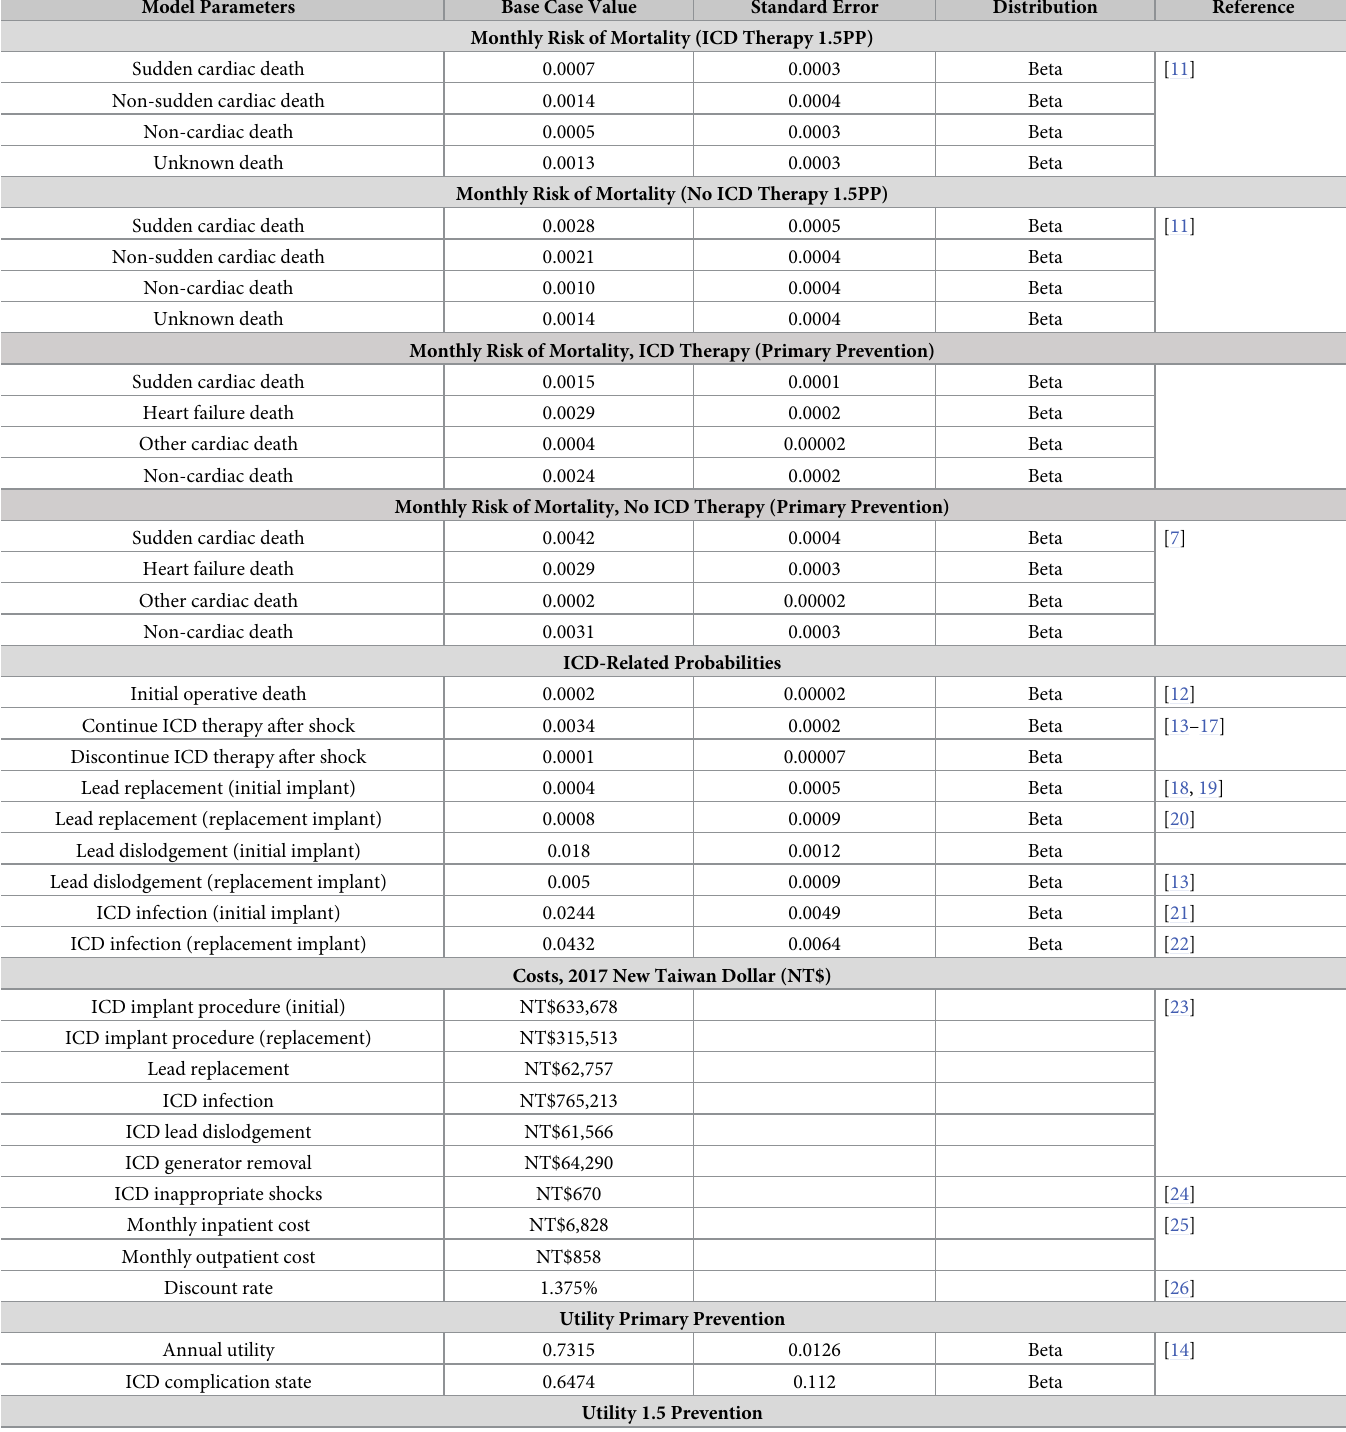
Table 1. Model input